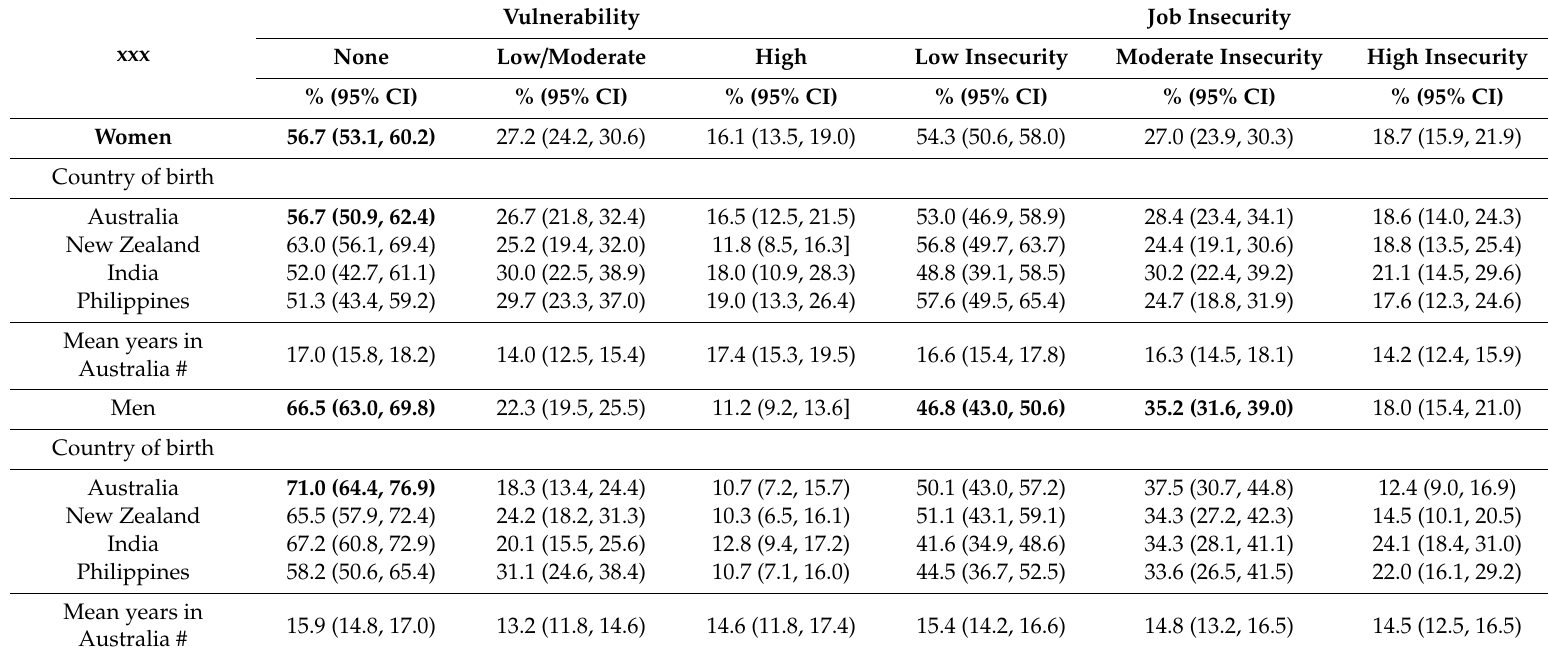
Table 2. Weighted prevalence estimates of levels of vulnerability and job insecurity by country of birth group for women and